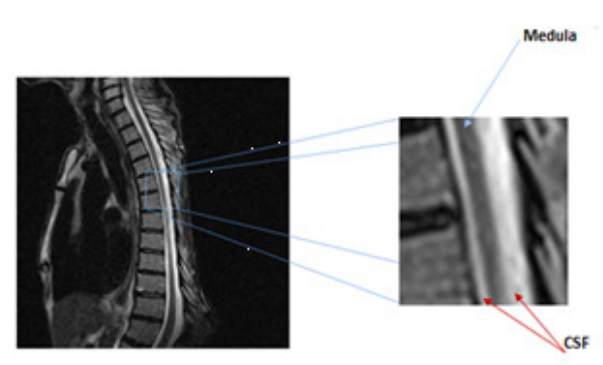
Figure 3. Region of the CSF in MRI type T2. Source: Hospital